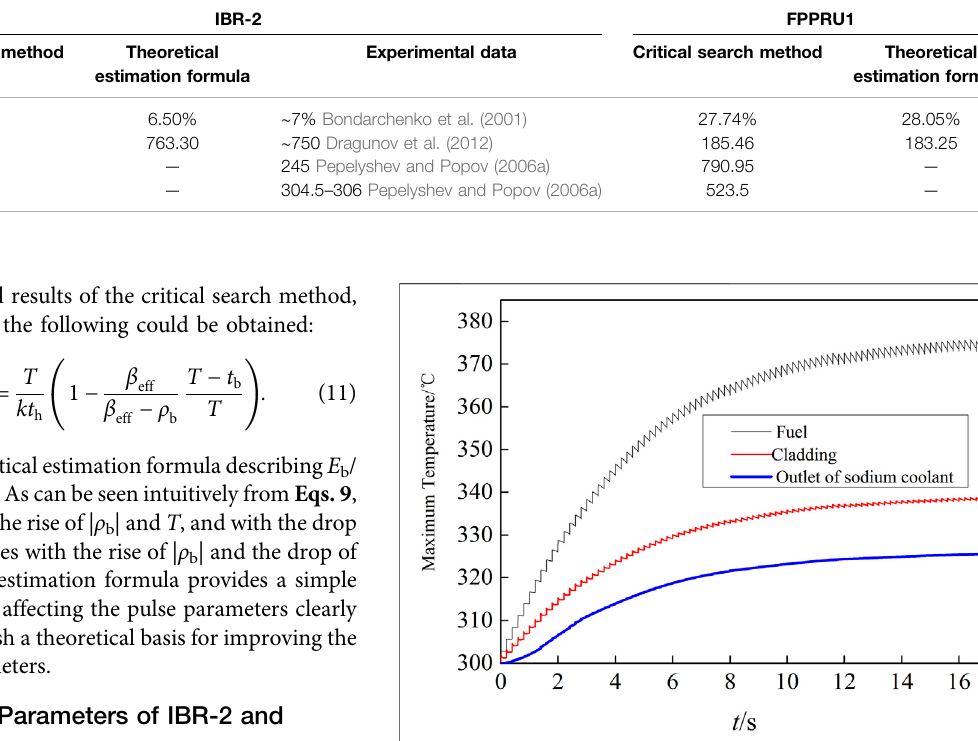
FIGURE 10 | The sub-channel model of the fuel assembly.